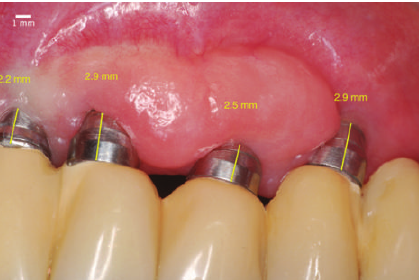
Figure 11: Postoperative aspect 21 days after surgery: note that the connective tissue graft failed to cover exposed threads.